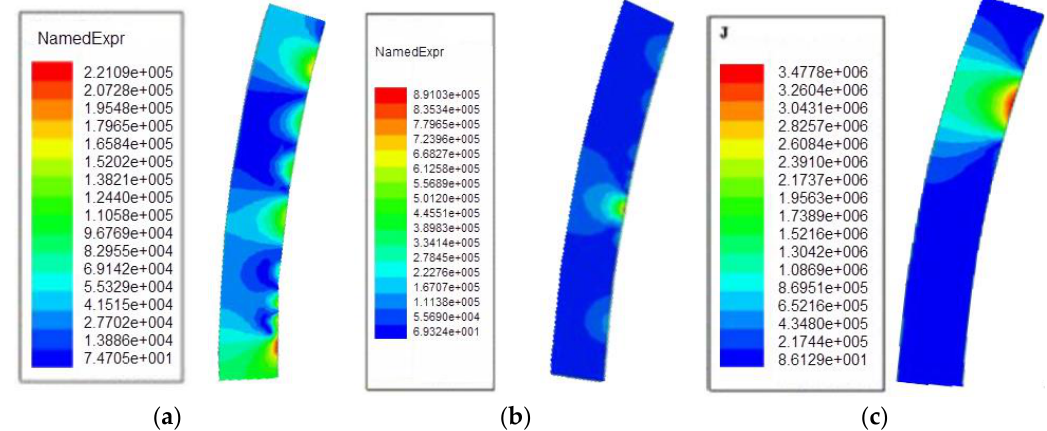
Figure 6. The eddy current density in the permanent magnet under no-load condition. ( a ) slot opening = 2 mm ( b ) slot opening = 4 mm ( c ) slot opening = 7 mm. opening = 2 mm ( b ) slot opening = 4 mm ( c ) slot opening = 7 mm.